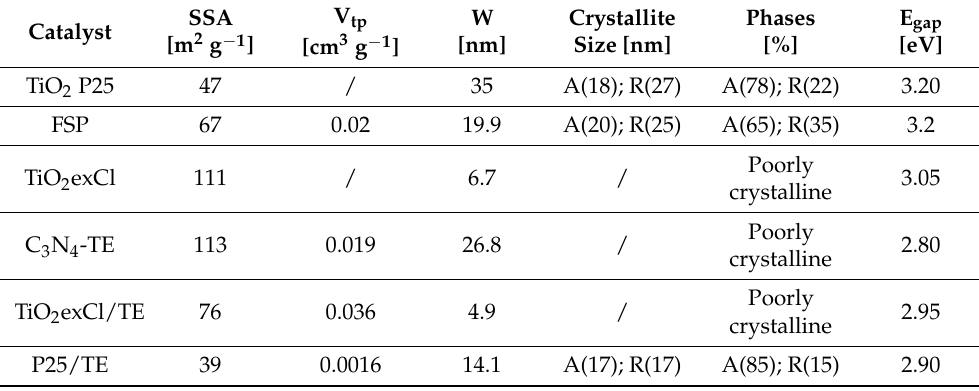
Table 1. Textural properties and physical-chemical features of the photocatalysts: BET specific surface area (SSA), t-plot micropore volume (V tp ), BJH adsorption pore width (W), crystallite size, phases percentage, and band gap values estimated from DR-UV-Vis spectra elaborated as Tauc